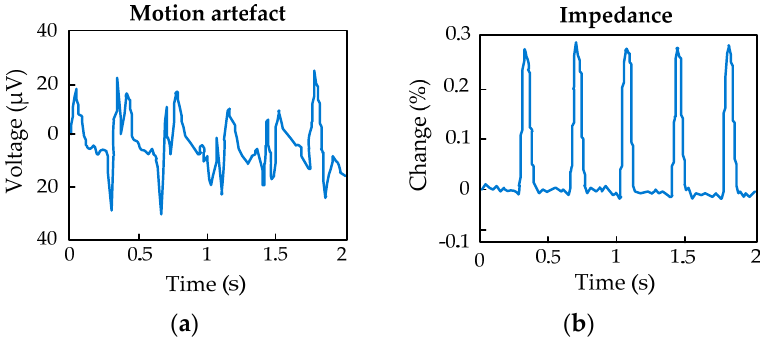
Figure 4. ( a ) Measurement of the motion artifact; ( b ) Real part of the electrode impedance at 16 Hz.